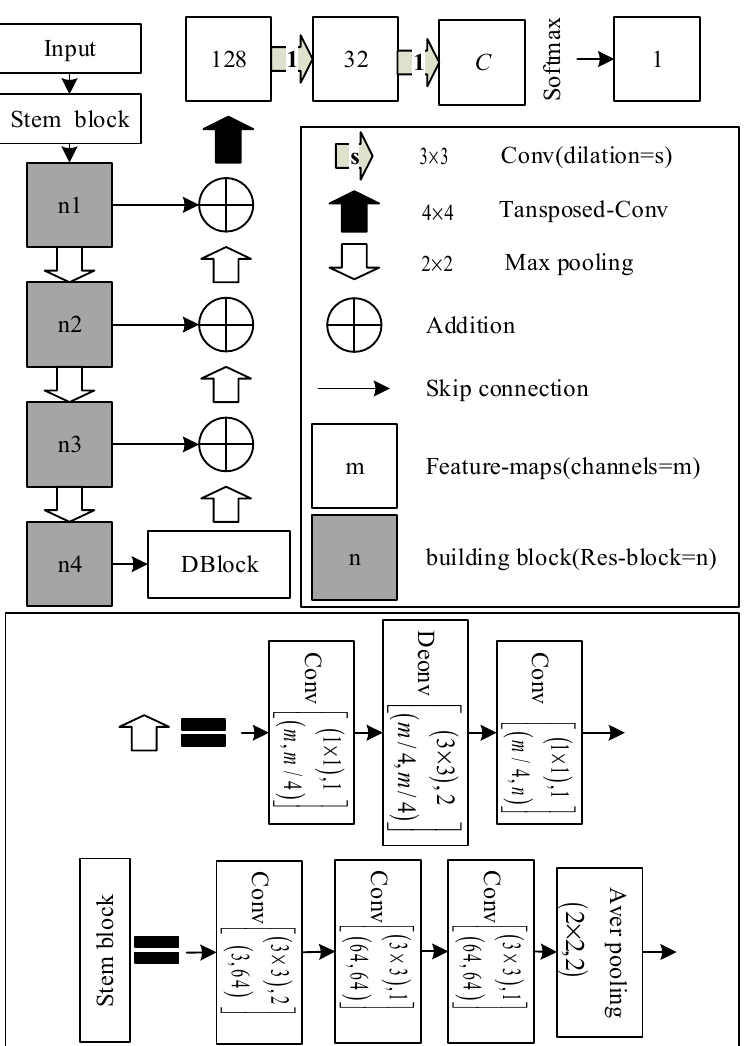
Figure 9. D-LinkNetPlus structure chart.